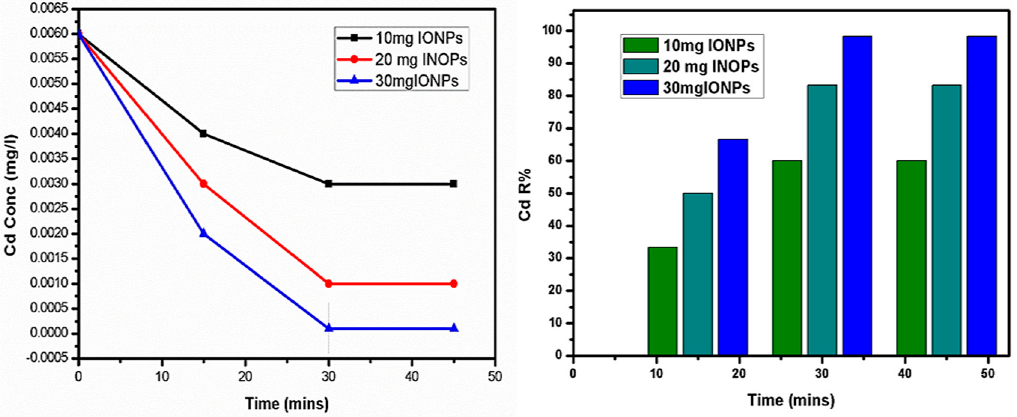
Figure 7. Removal of Cd using IONPs at different concentrations and their removal%.